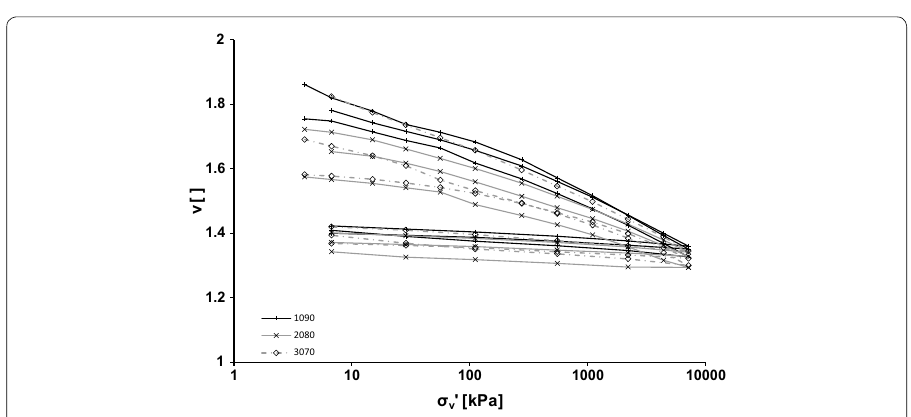
Fig. 4 One-dimensional compression data for the CDV